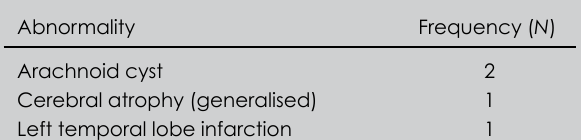
Table III. CT scan